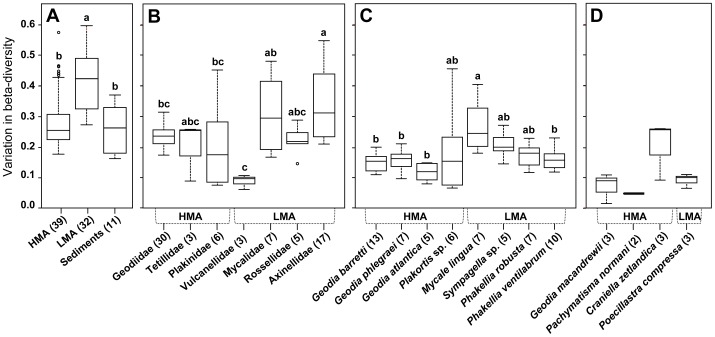
Bacterial community diversification.Variation in beta diversity, measured as the average degree of dispersion (i.e. the average dissimilarity from individual samples to their group centroid) among (A) sponge types and ambient sediments, (B) sponge families, (C) sponge species with more than 5 specimens per species, (D) sponge species with less than 5 specimens. Different lower-case letters above each box denote significant mean difference in dispersion based on pairwise Wilcoxon-Mann-Whitney testing at P<0.05. Species with less 5 specimens were not statistically compared.